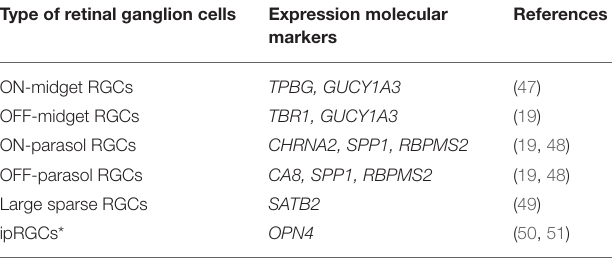
TABLE 2 | Antibodies used in immunohistochemistry for retinal ganglion cells. Antigen Host species Specificity